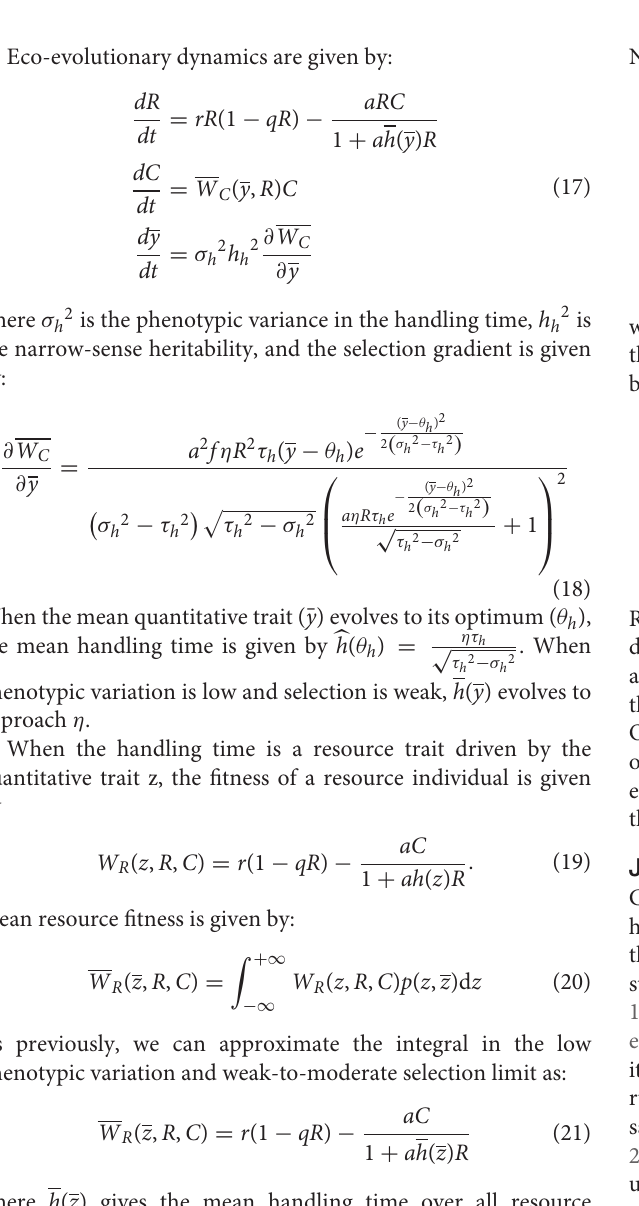
FIGURE 5 | a minimum under stabilizing selection ( phenotypic load imposed by σ h 2 even when σ h is low. (B,C,G–J) depict resource (black) and consumer (blue) abundances and (D–E,K–N) , the mean handling time [ h ( y ), orange line], the expect minimum of h ( y ) ( dashed red line). (B–E) show that the handling time can evolve toward its expected minimum ( albeit with resource abundances reaching extremely low levels at frequent intervals. (G–N) show that such interactions are susceptible to extinction at low abundances that curtails trait evolution. It is only when the attack rate is sufficiently low that the minimum resource abundance exceeds the levels that predispose it to extinction (I,J) , that the mean handling time evolves to its optimum (